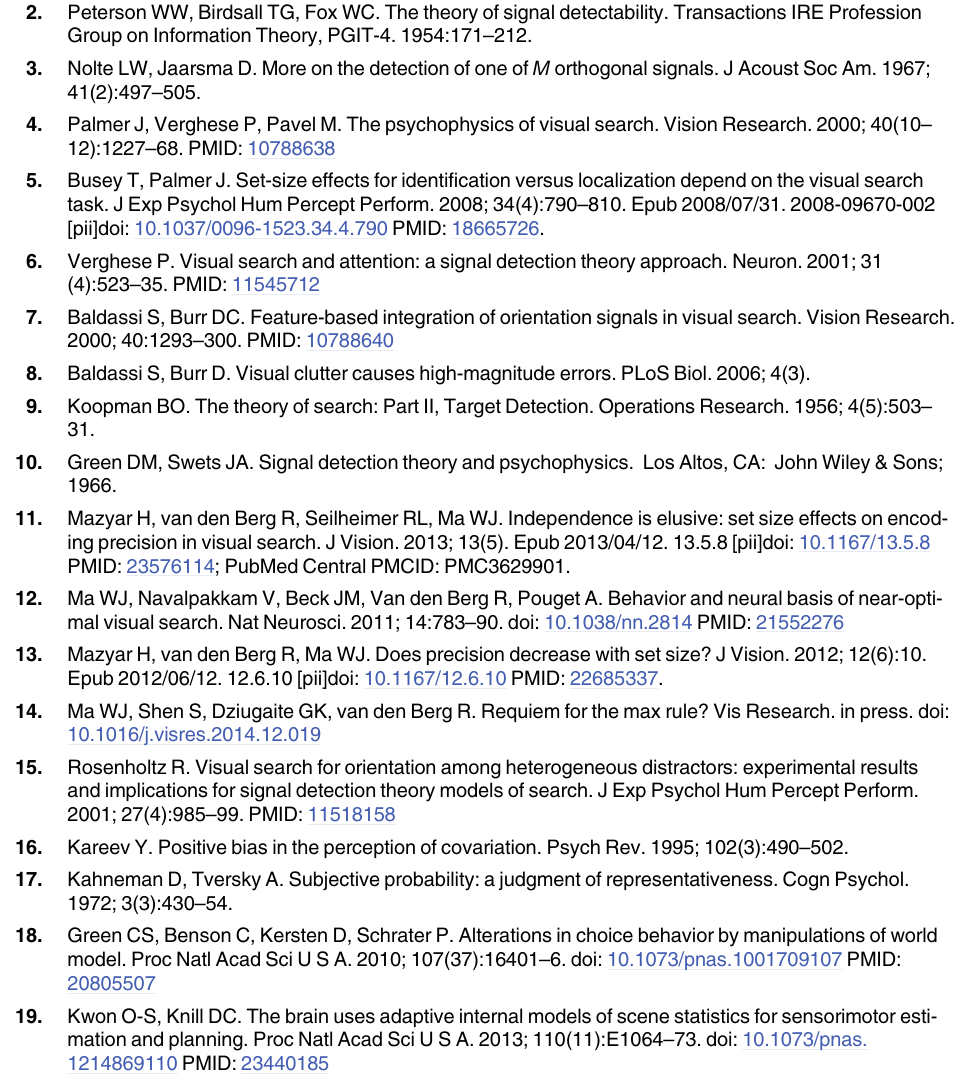
S1 Table. Parameter estimates. Means and standard error means of the maximum-likelihood estimates of all parameters in all models, as well the tested ranges of the parameters. S2 Table. Parameter recovery analysis for the VP4 model. Mean, standard error mean, and 95% confidence interval for ρ assumed